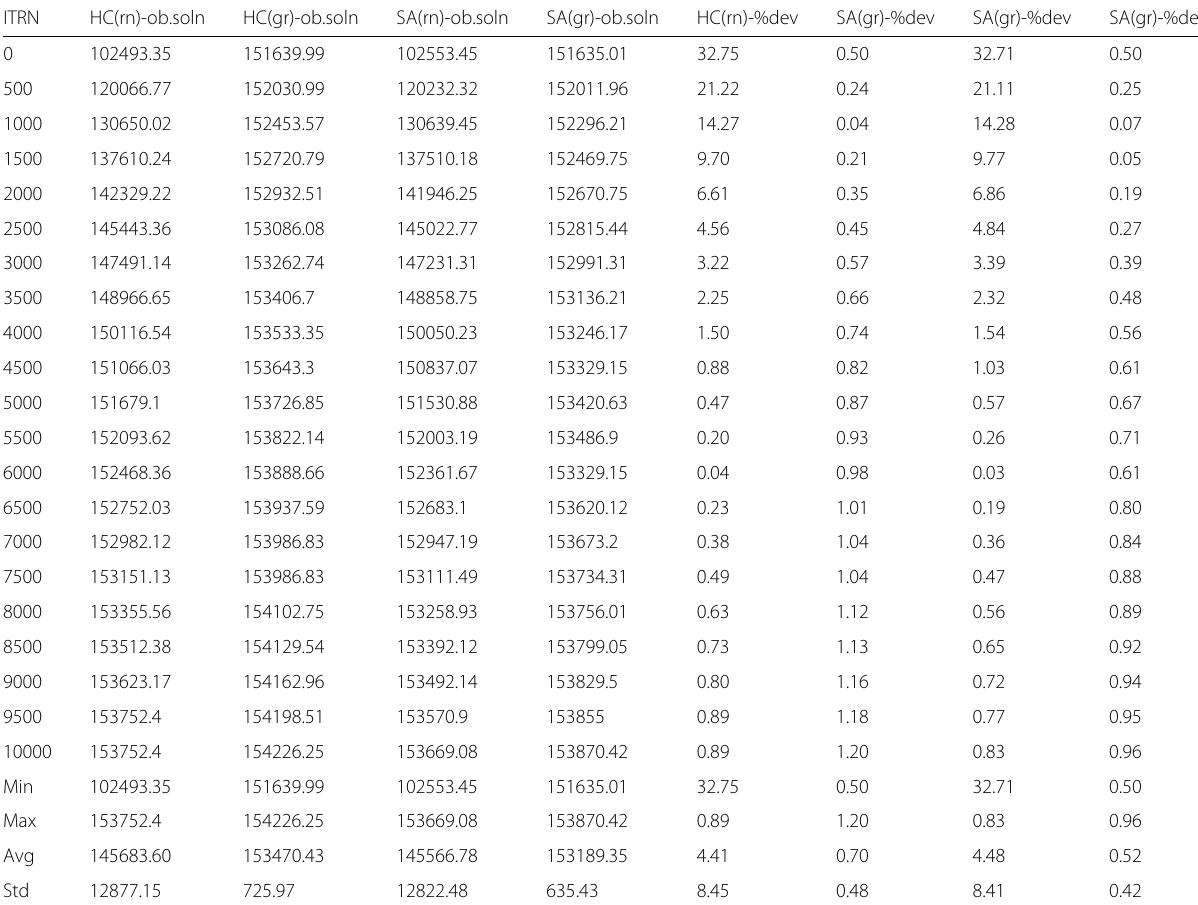
Table 8 Obtained solution (ob.sln) and Percent deviation(%dev) of obtained soln to the target soln - C(500,20,4) ITRN